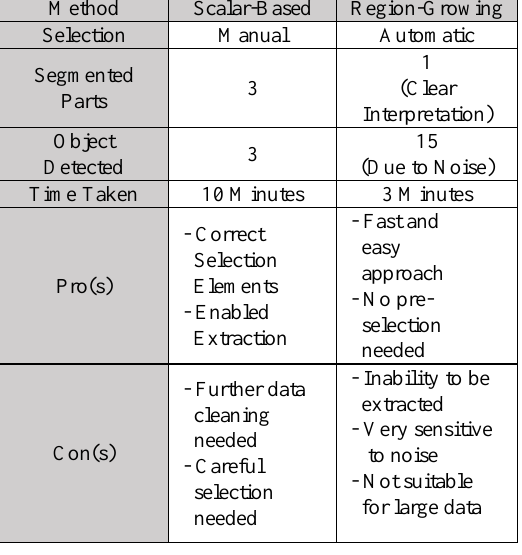
Table 3: Comparison between methods Based on the Table 3, the comparison between Scalar based method and Region Growing Segmentation